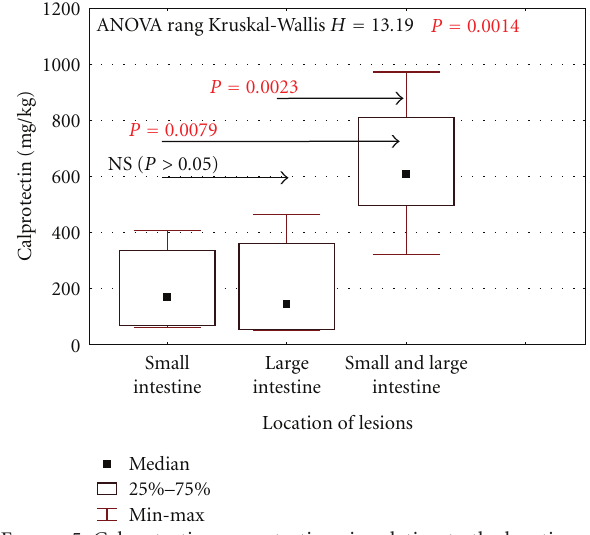
Figure 5: Calprotectin concentrations in relation to the location of lesions in CD